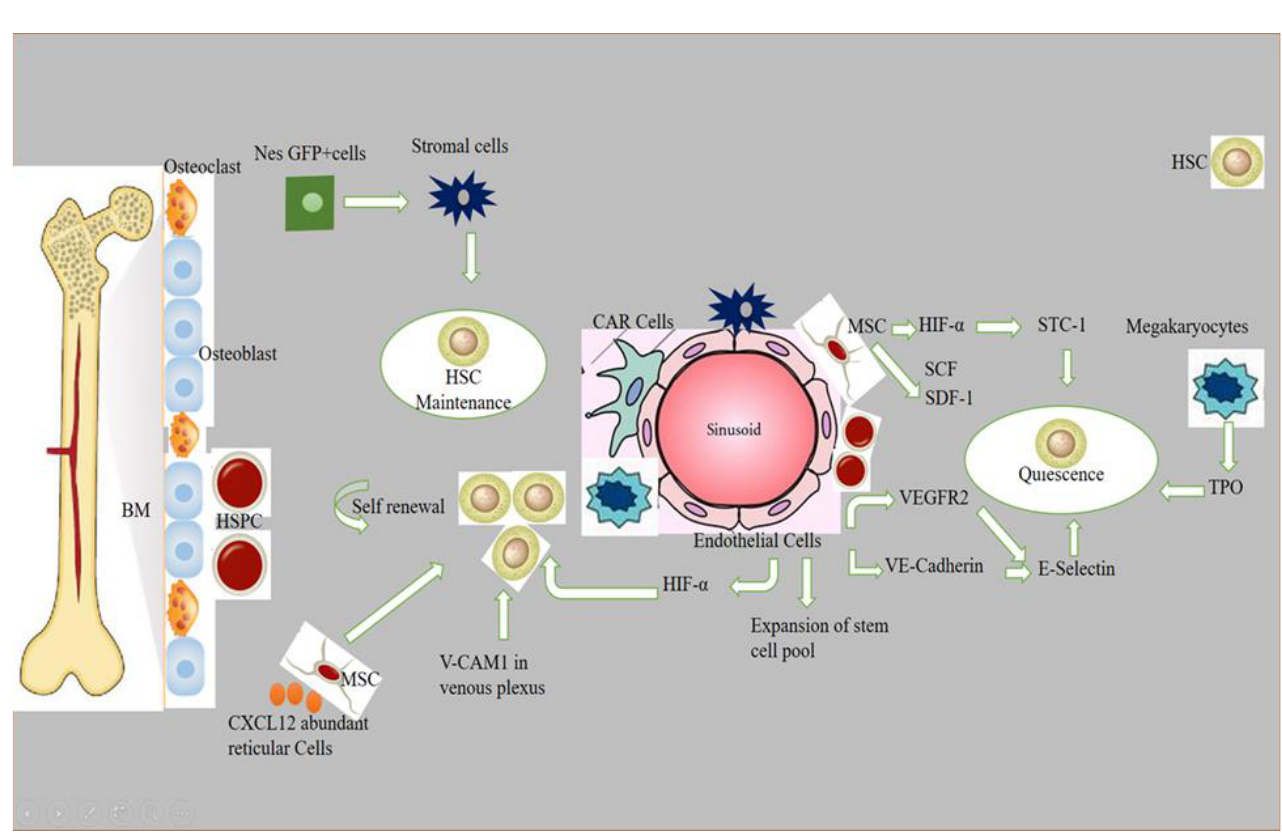
Figure 1. Role of different signaling factors responsible for hematopoietic niche maintenance and quiescence. A brief description of how normal HSPCs compete for microenvironmental space and resources. Niche cells, cytokines, signals, ECM, and oxygen gradient govern HSC activity. HSCs vary by subniche. Endosteal niches maintain LT-HSCs, while sinusoidal niches aid in hematopoietic development and regeneration. NG2+ arte-riolar pericytes block HSCs from shutting arterioles. LepR-expressing perisinusoidal cells produce SCF and CXCL12, required for HSC maintenance or mobilization. Different niches and subniches serve hematopoiesis.